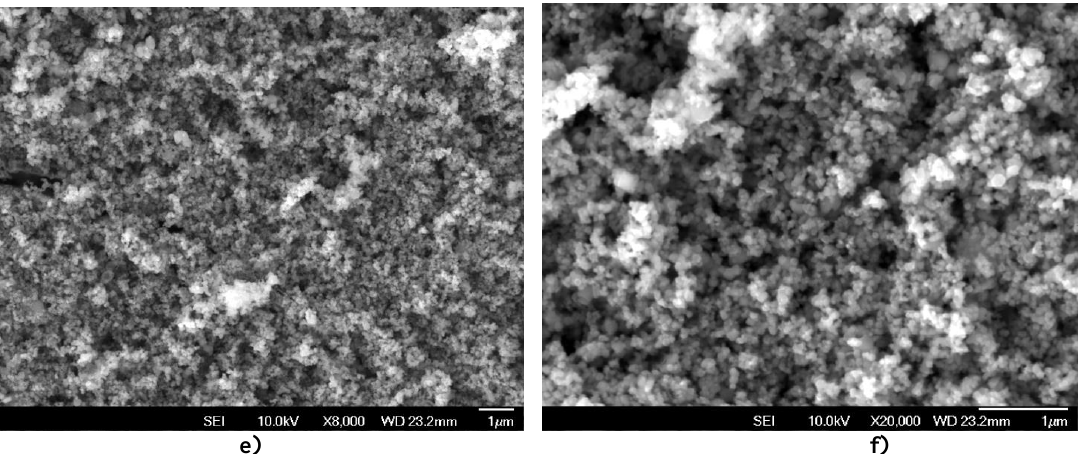
Fig. 4. SEM image of nanoscaled coating of different zoom of the same area: a) 550; b) 1000; c) 2000; d) 4000; e) 8000;